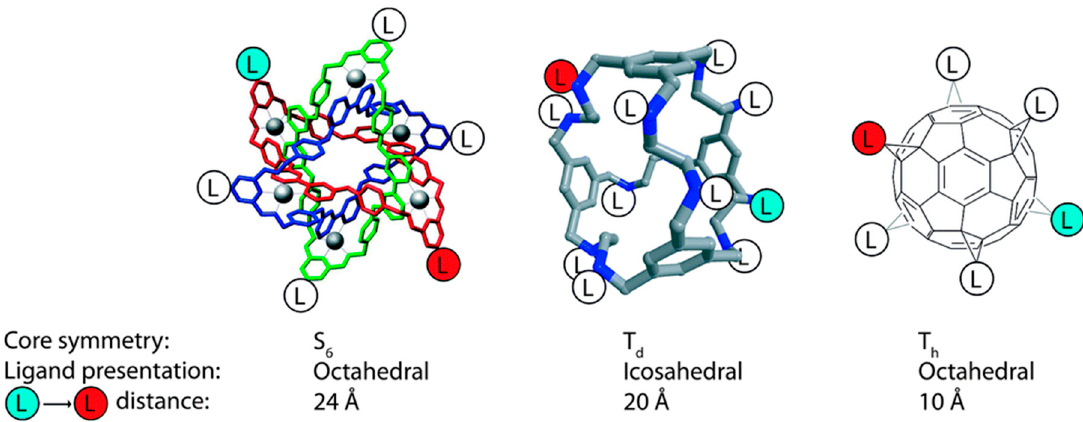
Figure 11. Symmetry and size of nanoscaffolds (from left to right): molecular Borromean rings, dodecaamine cages and fullerenes applied for glycan immobilization with subsequent examination of kinetic and affinity parameters for binding to Con A. Reproduced with permission from [115]. Copyright the Royal Society of Chemistry, 2016.